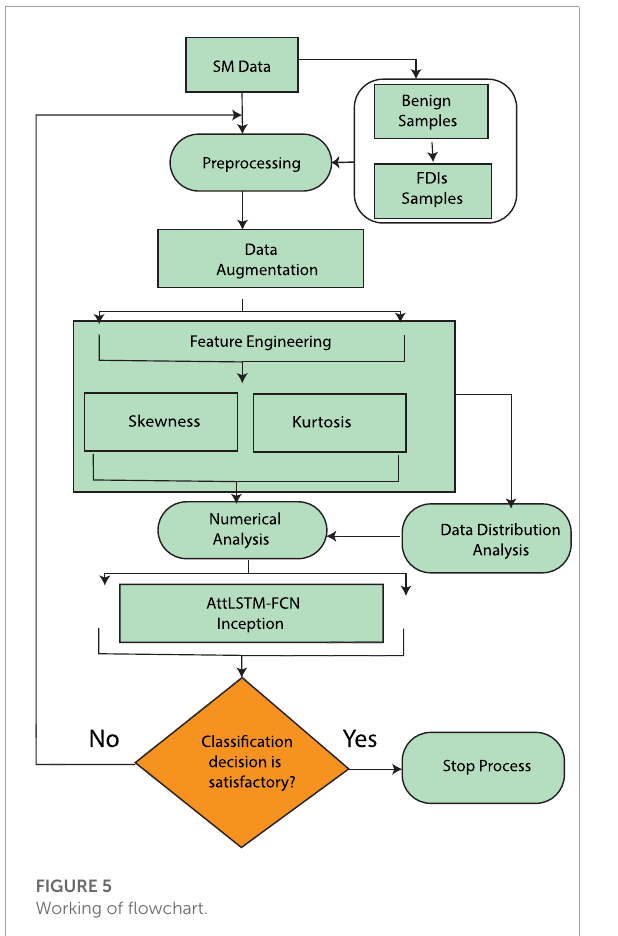
Algorithm2. AttenLSTMInceptionbasedElectricityTheftDetectionScheme.